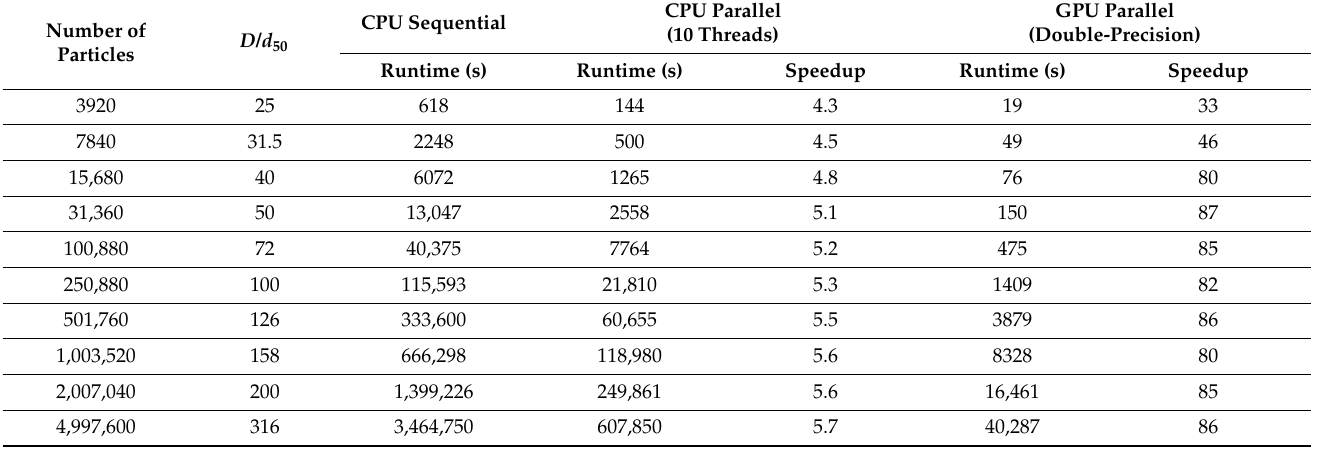
Table 1. Speedups of CPU and GPU parallel simulations in triaxial test cases (10,000 incremental steps, d 50 = 3.2